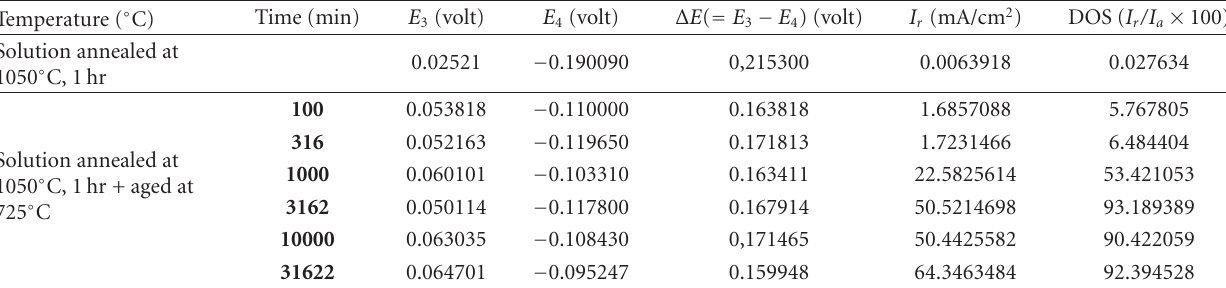
Table 6: DLEPR test results on the reverse scans of polarization